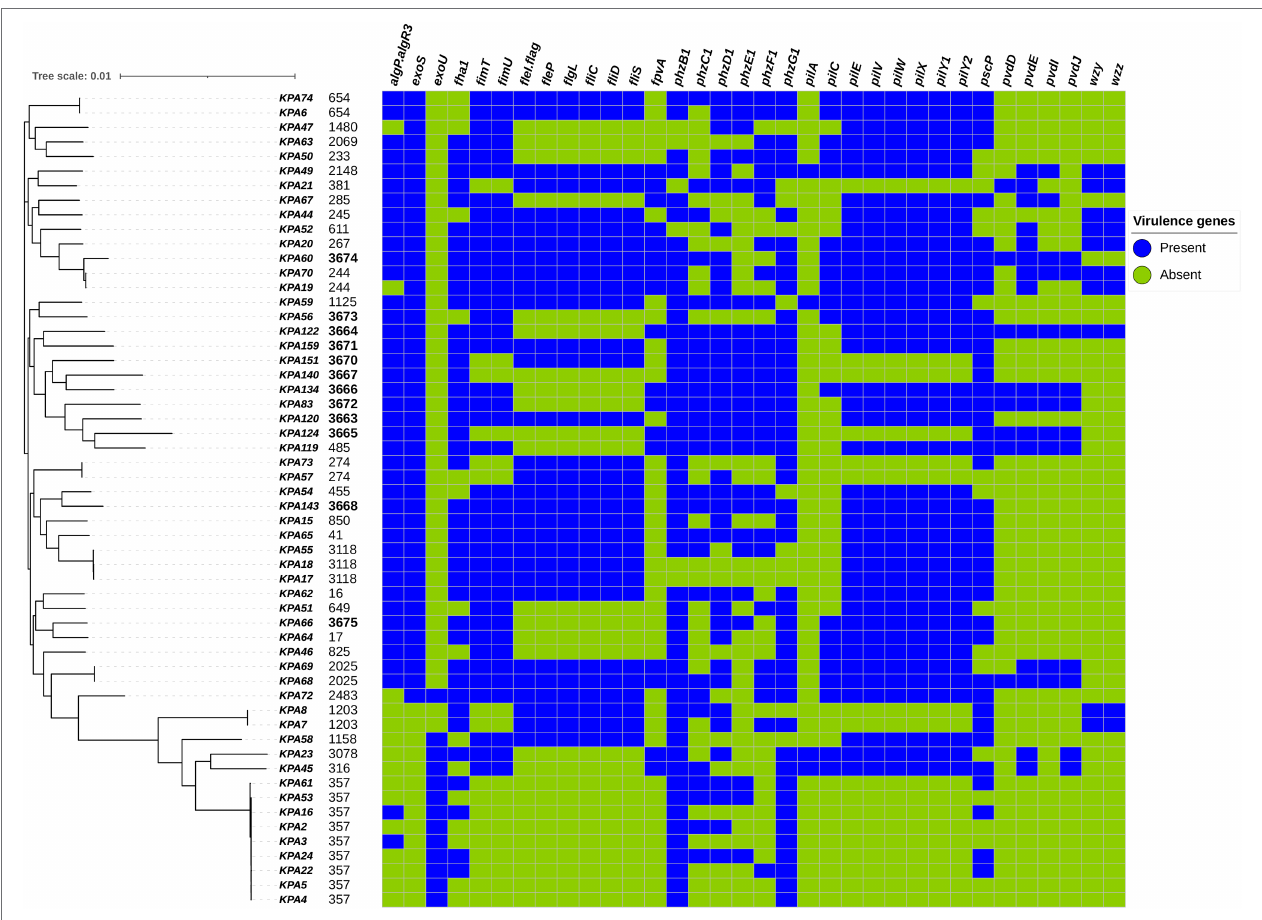
FIGURE 4 | Distribution of variably present virulence genes among Pseudomonas aeruginosa isolates mapped on the maximum-likelihood phylogenetic tree of all study isolates, and the presence and absence of virulence genes as detected by the Virulence Factor Database (VFDB) are